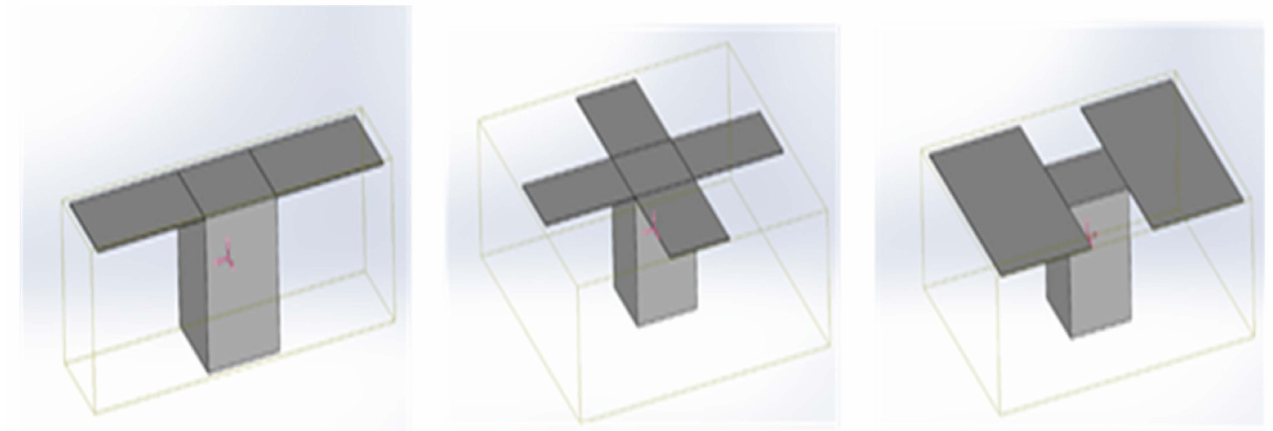
Figure 13. Solar panel deployment types defined as solar array area ratios (1, 2, and 3 from left to right